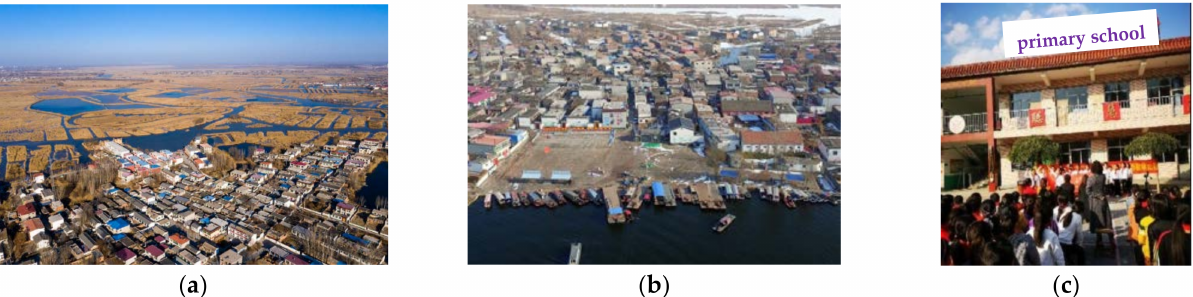
Figure 1. 1 typical electricity scenes: ( a ) villages; ( b ) docks; ( c )